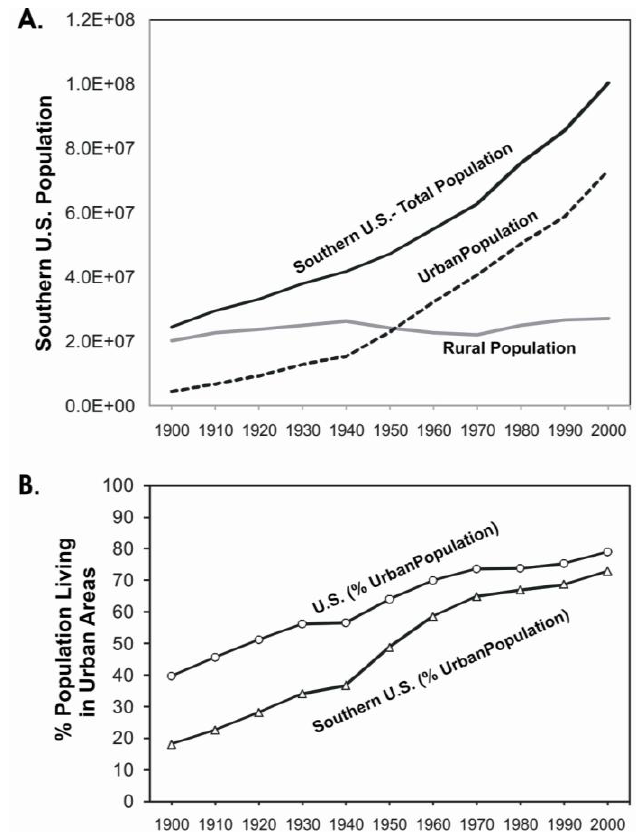
Figure 2. (A) Population change for the period 1900–2000 in the southern U.S. and (B) the percentage of U.S. and southern U.S. population residing in urban areas (source: U.S. Census).